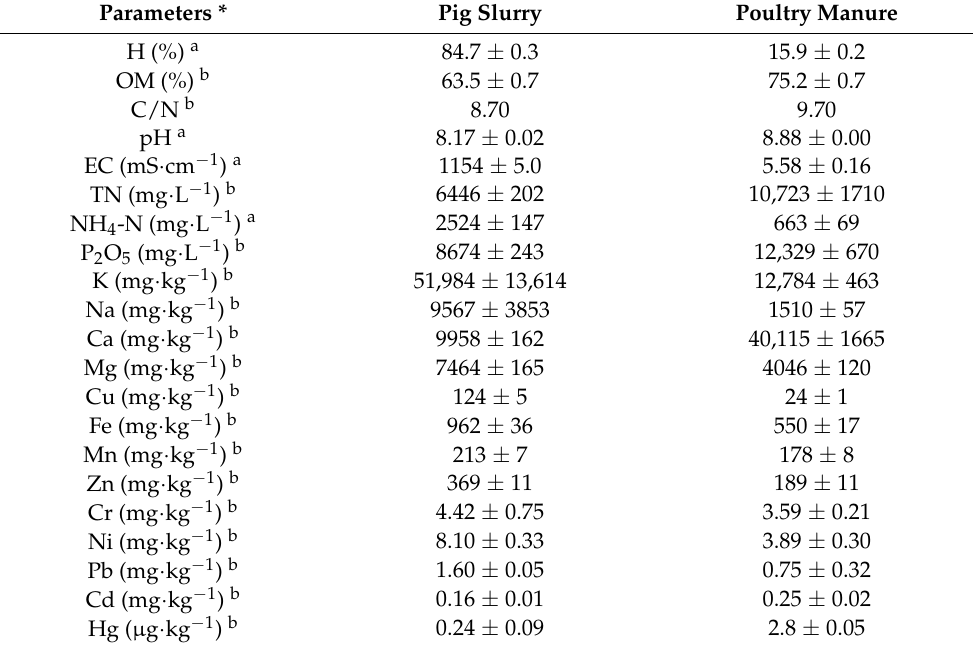
Table 1. Chemical characterization of pig slurry and poultry manure.